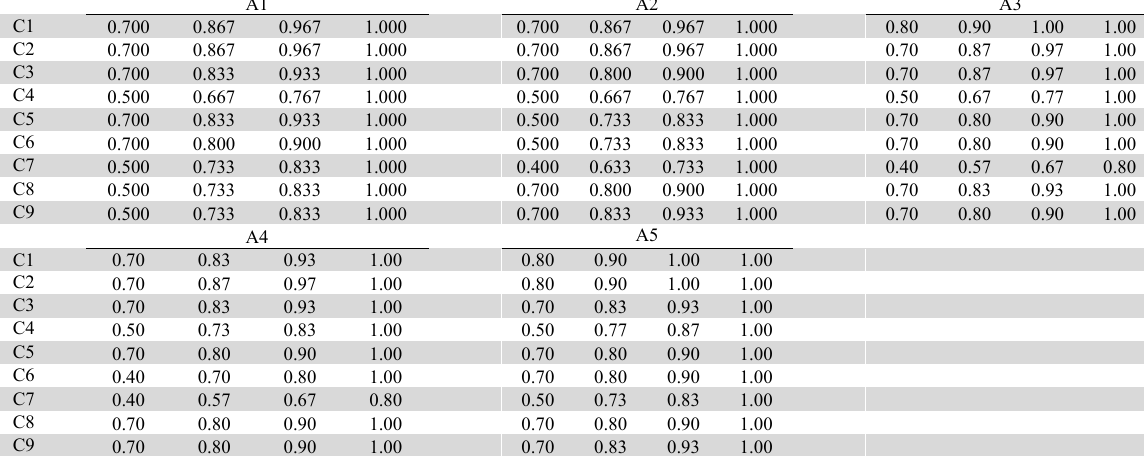
Aggregated ratings of the measures with trapezoidal fuzzy number A1